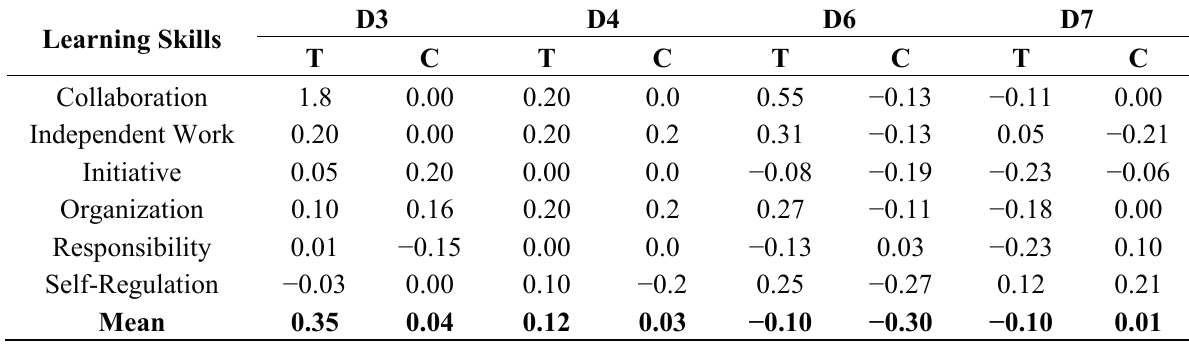
Table 4. Changes in Learning Skills Results by Treatment (T) and Control (C)